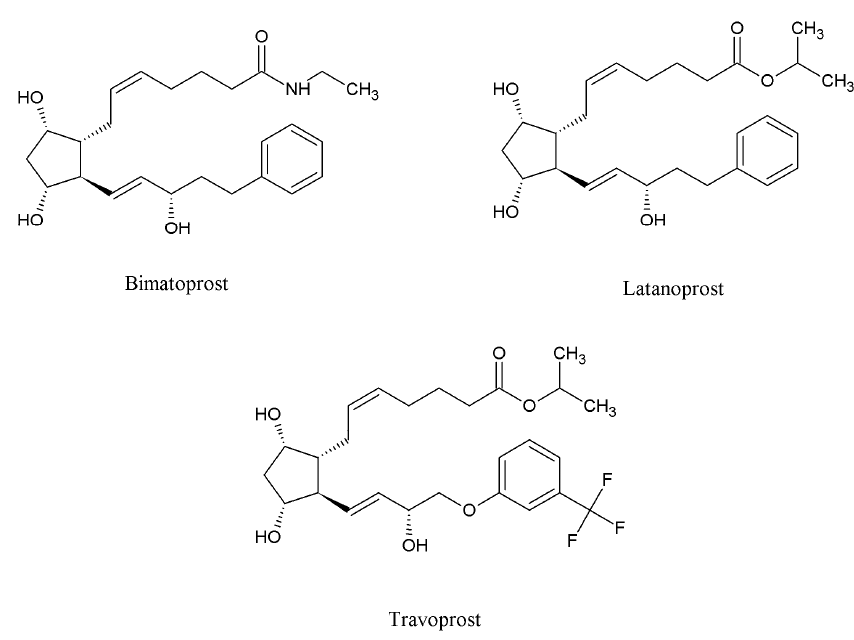
Figure 1. Structures of the prostaglandin analogs under investigation.